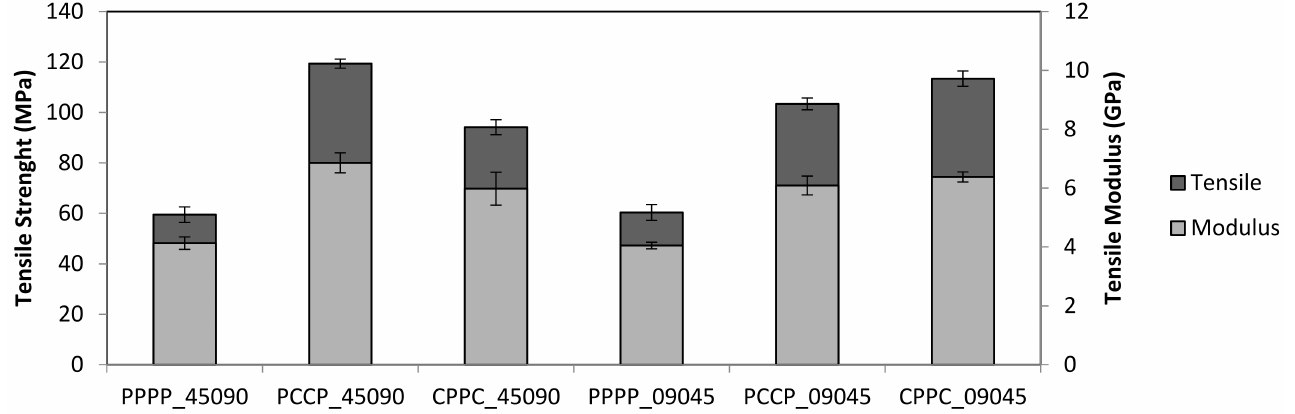
Figure 1. Tensile properties of the